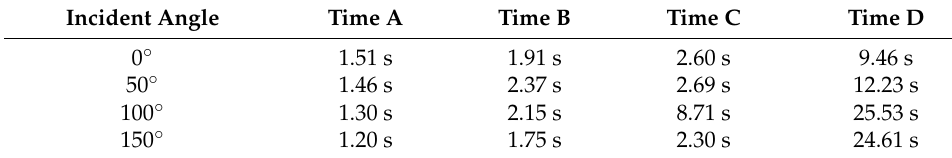
Figure 5. Deformed shapes of the tank structure: ( a ) nonlinear analysis; ( b ) linear analysis. Table 3. Times at which the evolution of tensile damage is